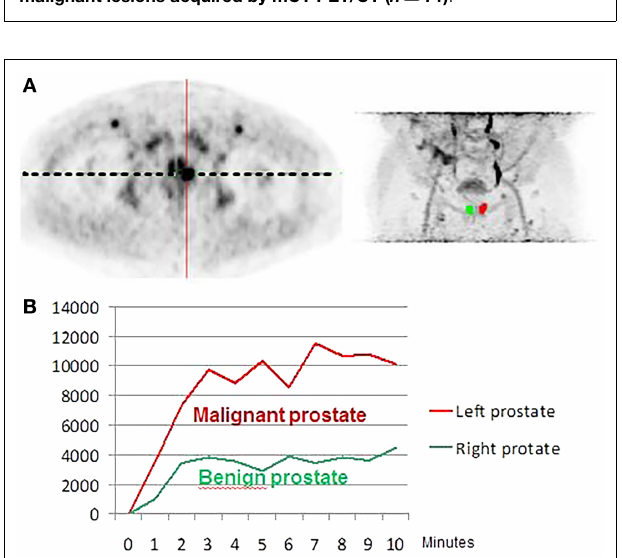
FIGURE 2 | (A) Axial early FCH PET/CT acquisition (mCT PET/CT instrument), (B) maximum intensity projection (MIP) in the same patient. Patient evaluated before initial surgery with a prostatic adenocarcinoma, Gleason 3 + 4, PSA at 10ng/mL. Histological analysis showed a left prostatic adenocarcinoma (red curve) while the right lobe was free of disease (green curve): statistically significant difference of tracer uptake between the two lobes was